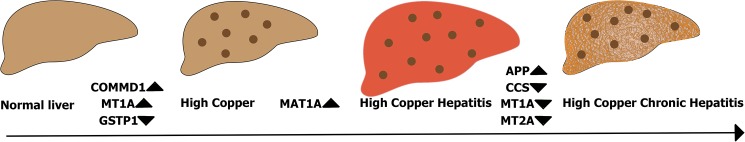
Copper metabolism adaptation in disease progression.A schematic overview of up- or downregulated of genes, involved in copper metabolism and oxidative stress within the different stages of disease progression. APP, amyloid beta (A4) precursor protein; CCS, copper chaperone for superoxide dismutase; COMMD1, copper metabolism (Murr1) domain containing 1; GSTP1, glutathione s-transferase pi 1; MAT1A, methionine adenosyltransferase I alpha; MT1A, metallothionein 1A; MT2A, metallothionein 2A.